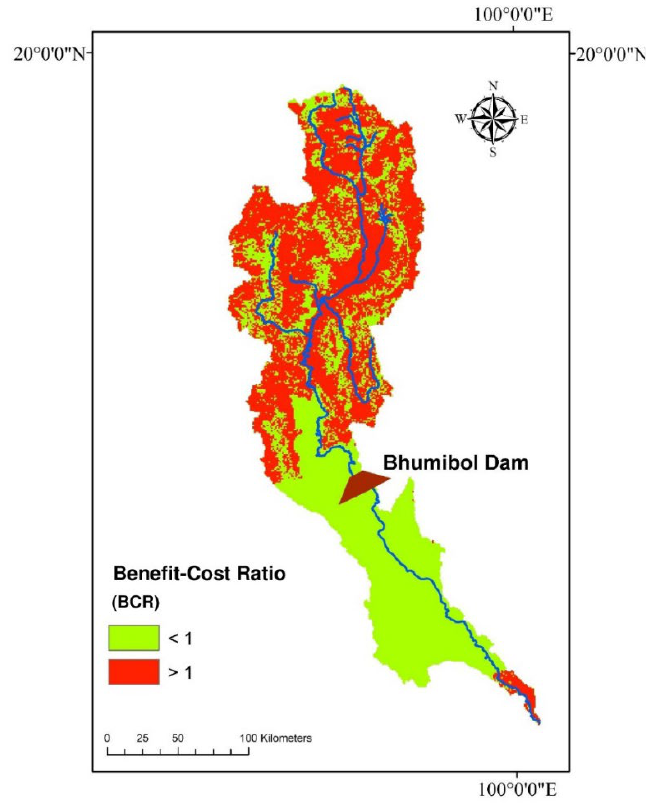
Figure 13. Benefit-cost ratio of sediment resources in the PRB.